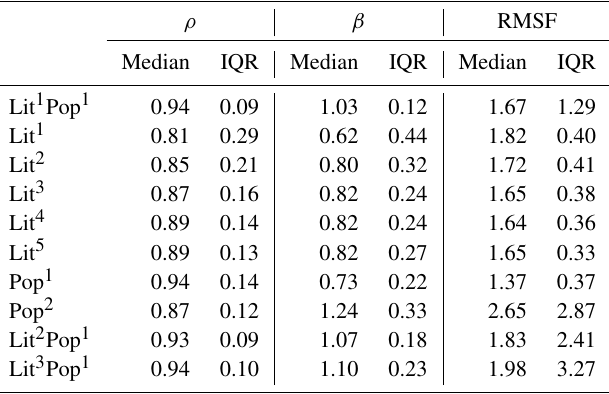
Table A3. Comparison of three skill metrics measuring the fit between modeled and reference nGRP. The table shows the median and IQR over 14 countries computed from the data in Table A2a–c. Perfect fit would mean a value of 1 for each metric.